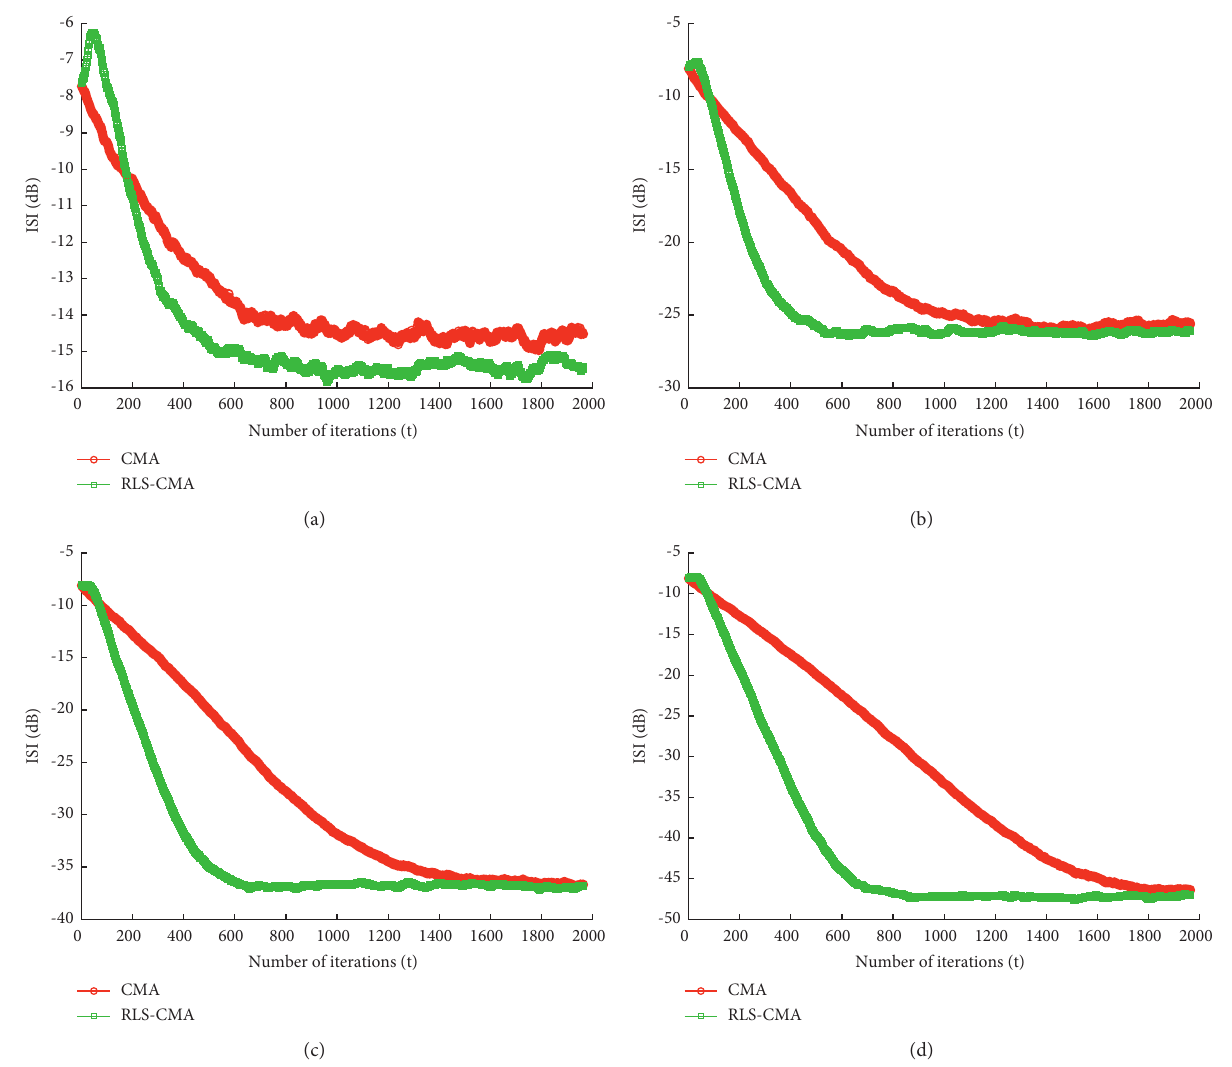
Figure 6: Relationships between the number of iterations and the ISI of the QPSK-modulated signal obtained for different blind equalisation algorithms at SNR � 15–45dB: (a) SNR � 15dB. (b) SNR � 25dB. (c) SNR � 35 dB. (d) SNR �